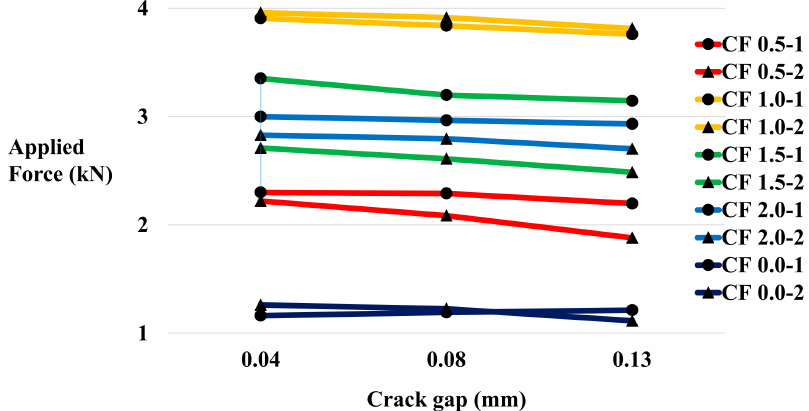
Figure 3. Flexural strength of prism samples of different fiber percentages. CF 1.5- shows most variation for different